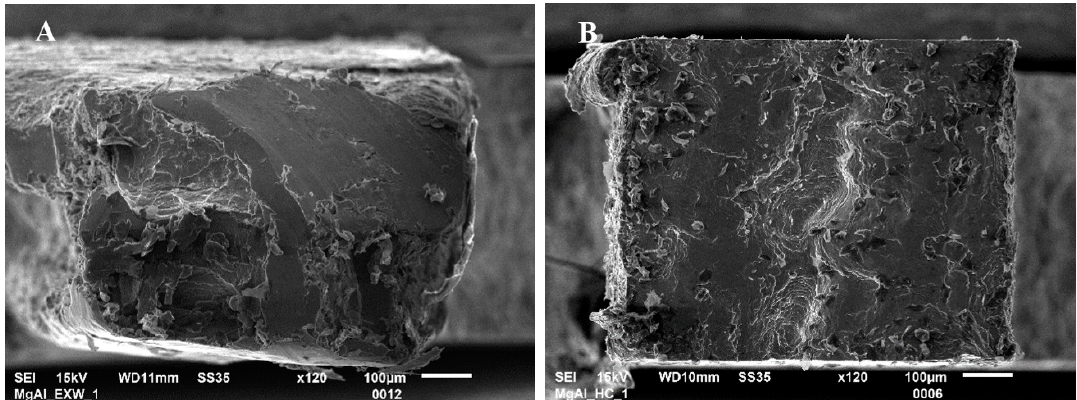
Figure 7. The fracture surface of Mg/Al mini-specimen in the as-welded state ( A ) and after hot-rolling at 400 °C ( B ).